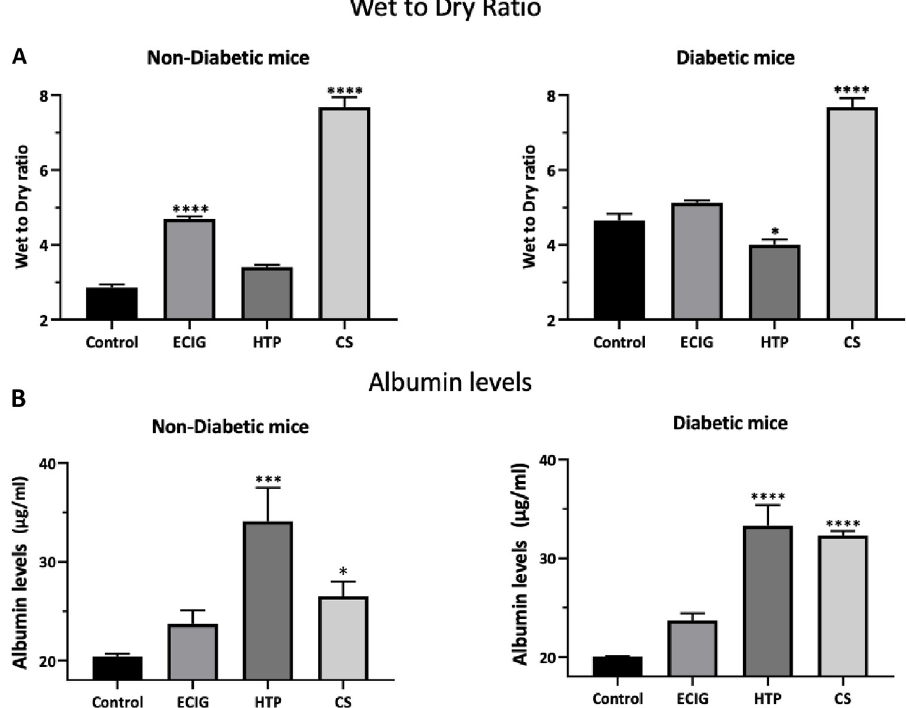
Fig 2. Mean wet to dry ratio (W/D) (A)and albumin level in the BALF (B) of Control, ECIG and CS for Non- Diabetic and Diabetic mice. Error bars represent SE. Asterisks indicate statistically significant associations ( �